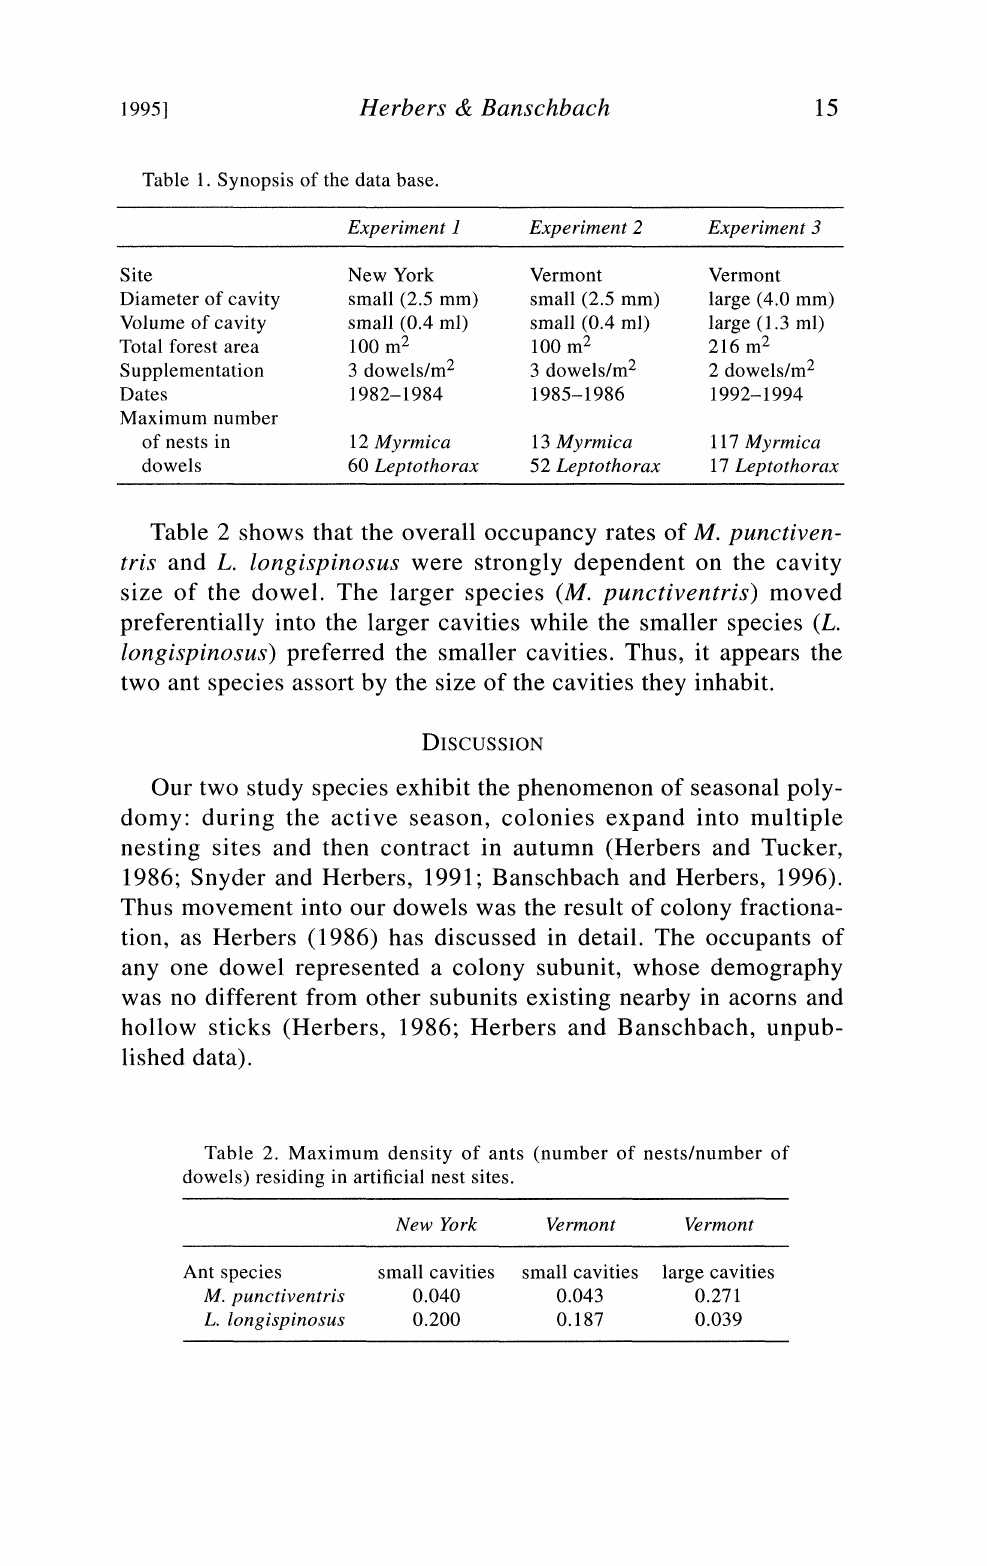
Table 2. Maximum density of ants (number of nests/number of dowels) residing in artificial nest